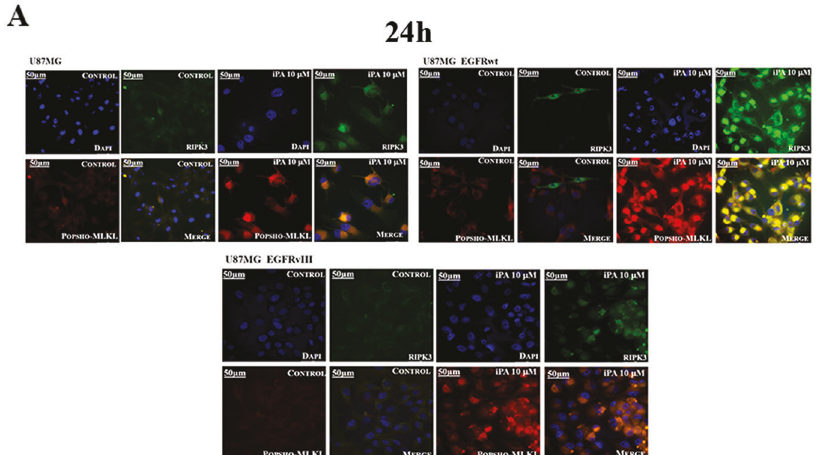
Fig. 5 iPA increases formation of necrosomes. A Immuno fl uorescence staining of U87 GBM cell lines with RIPK3 (green) and p-MLKL (red) after treatment with iPA 10 µM at 24 h. The nuclei were stained blue with Hoechst. The merged images show the necrosome formation in yellow due to the signal overlap of RIPK3 and p-MLKL (green + red). The data are presented as mean ± SD of at least three independent experiments. Cell Death Discovery (2022)